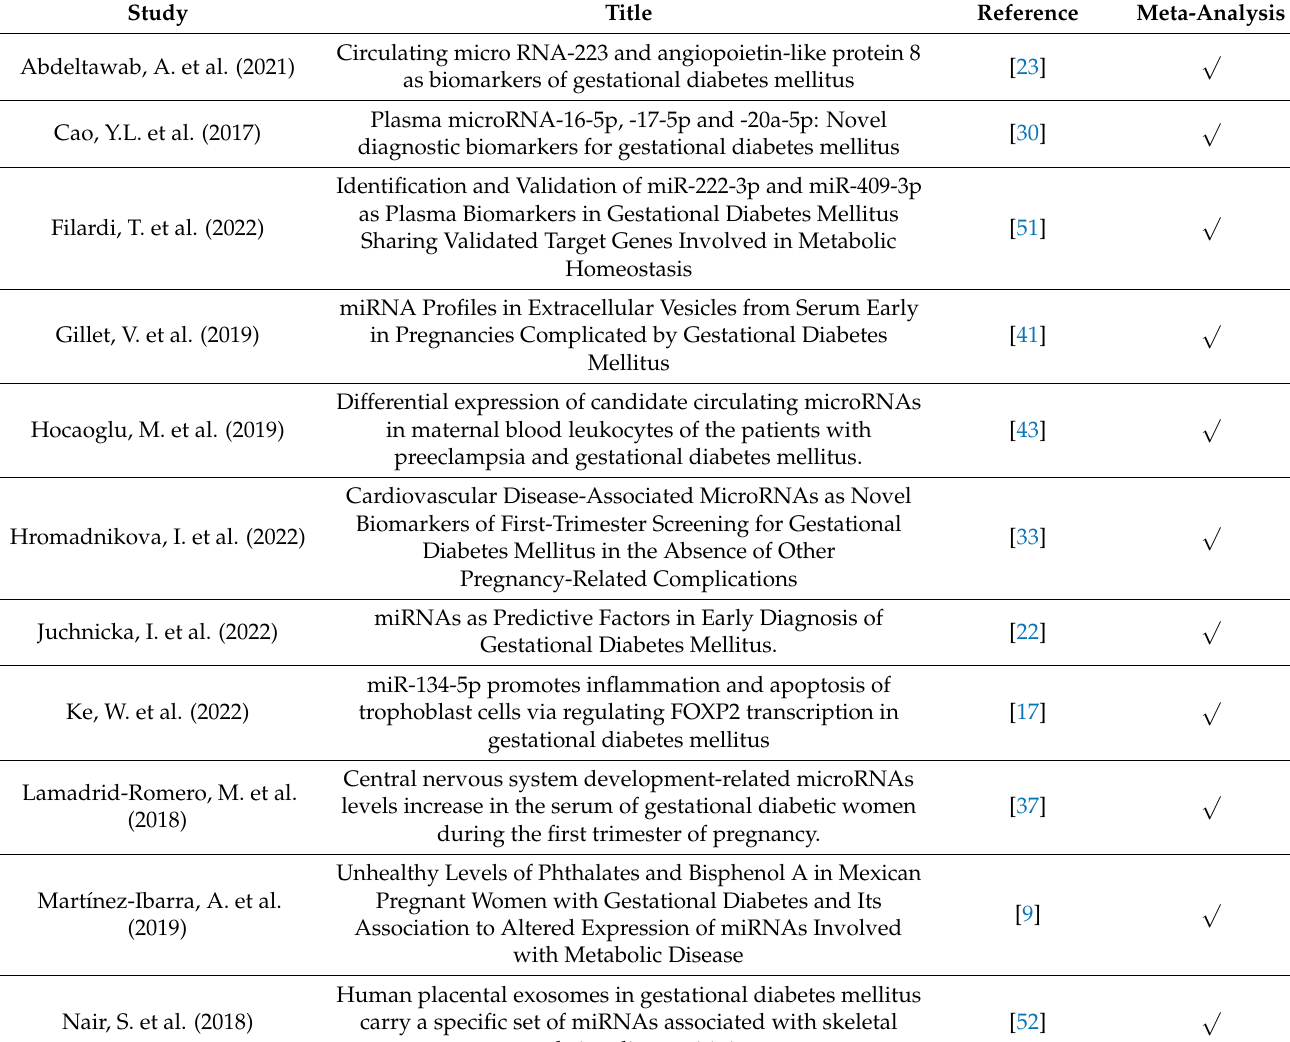
Table 1. Studies included in the meta-analysis part of the systematic